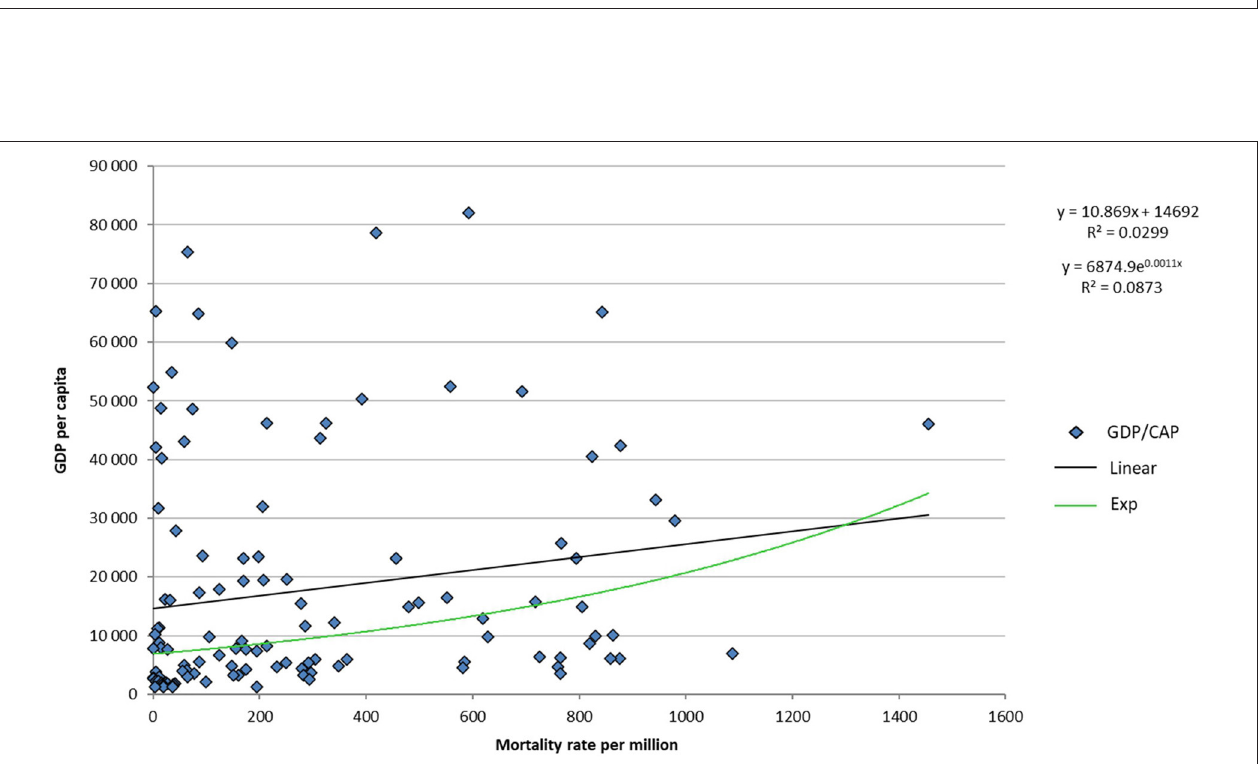
FIGURE 2 | Relationship between GDP per capita and mortality rate per million inhabitants for 120 countries with more than one million inhabitant and a GDP per capita greater than $1,200.